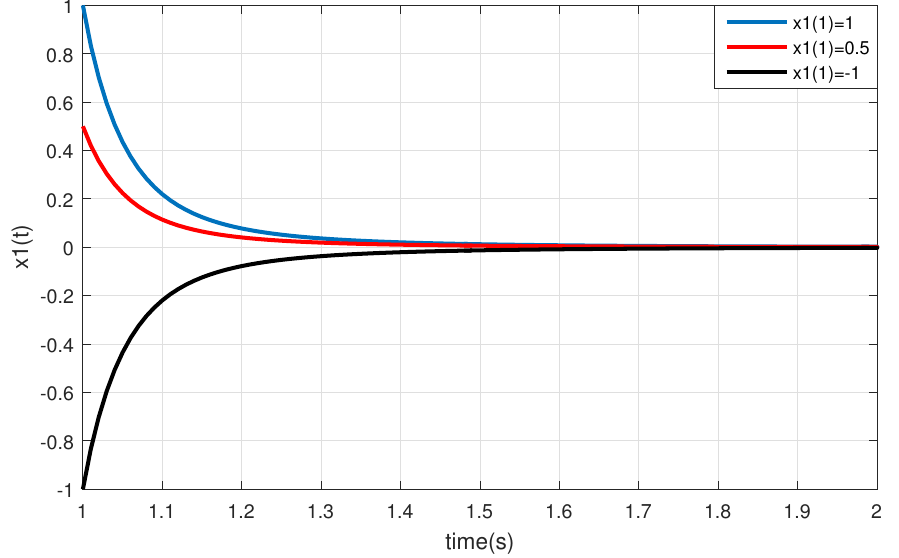
Figure 1. This figure shows that the solution x 1 ( t ) of the system of DDEs (11) with two multiple time-varying delays is uniformly asymptotically stable and the norm of this solution is integrable